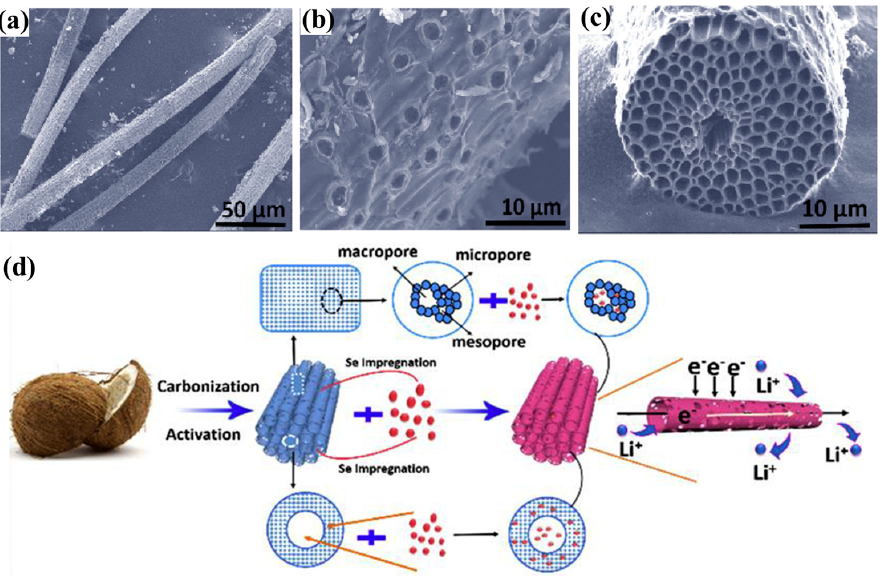
Figure 3. ( a – c ) FESEM images of HPTCs, ( d ) schematic of loading Se active materials and the transport paths for Li + and electrons in the HPTCs/Se tubular structure. Reproduced with permissions from the ref. [45] Copyright © 2017 Elsevier Ltd.